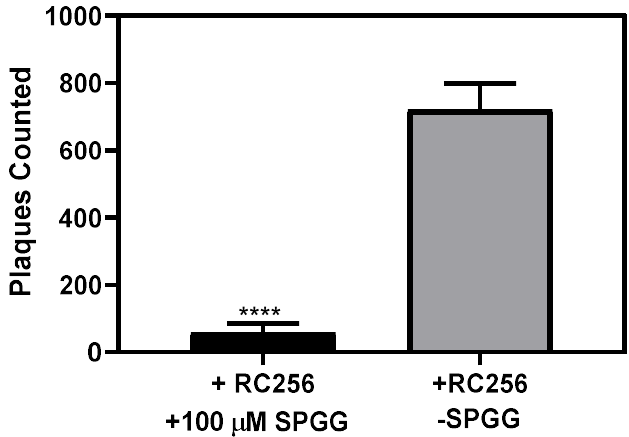
Figure 5. HCMV-mediated foci formation using plaque reduction assay in presence of SPGG. In the experiment, HFF-1 cells were infected with an MOI of 1.0 of HCMV β-galactosidase-expressing reporter virus strain (RC256) pretreated with 100 µM SPGG or mock-treated in serum free media (SFM). The number of plaques was quantified in both treated and untreated samples and revealed a dramatic decrease in samples pretreated with 100 µM SPGG compared to mock treatment. The graphs are the result of mean values and SD for a N = 3 experiments with triplicates of each conditions. Statistical significance was determined with a T-Test, (****) signifies a P -value of < 0.0001. 2.5. SPGG Inhibition of HCMV Entry Arises Partially from Binding to Glycoprotein B (gB)